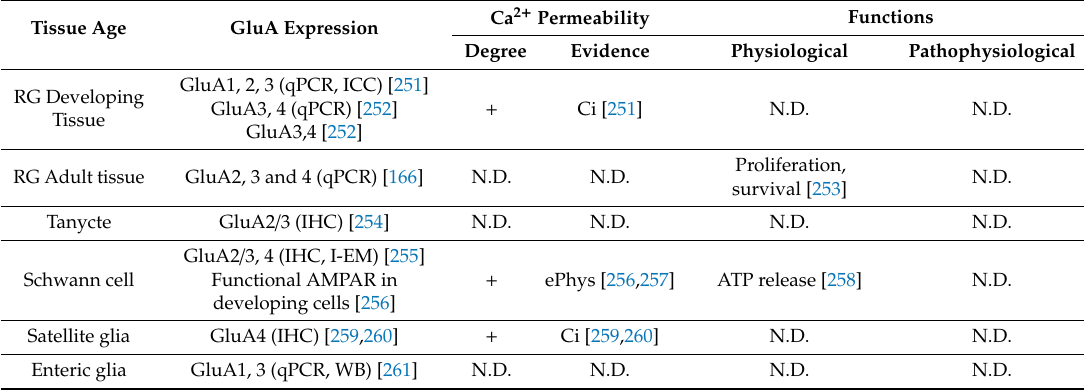
Table 4. Summary of AMPAR expression and functions in other